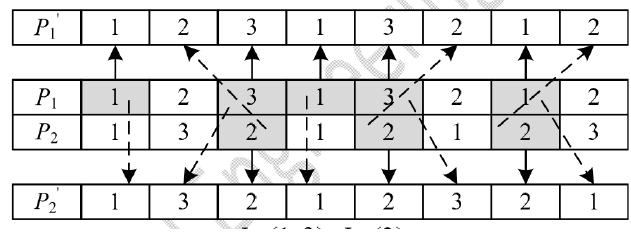
Figure 3. Crossover of processing